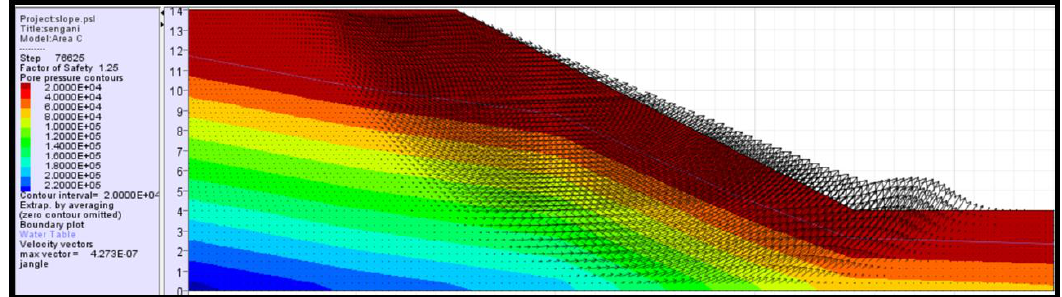
Figure 37. Simulated water pore pressure of the soil slope using FLACSlope in rainy conditions with a water table with 2000 m 3 volume of water.